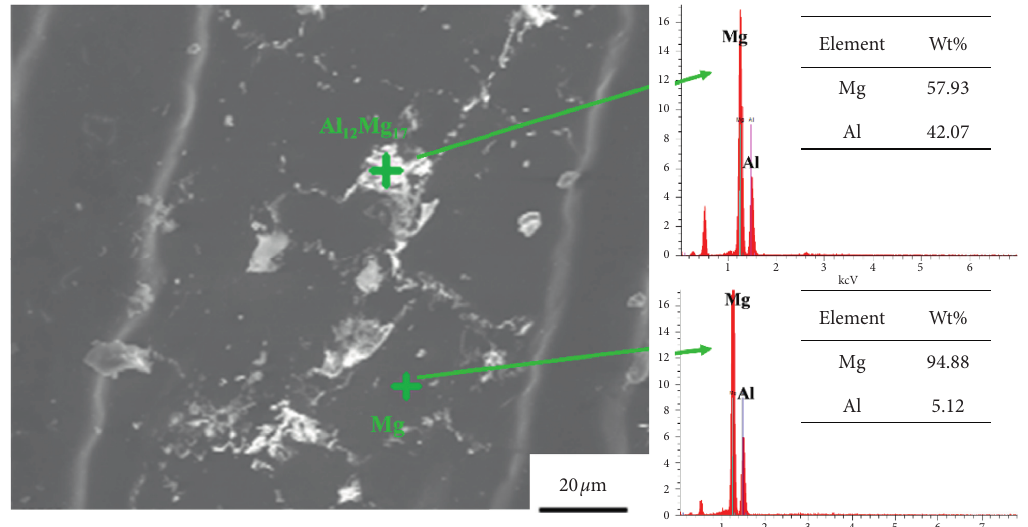
Figure 14: SEM view and the EDS element analysis of the